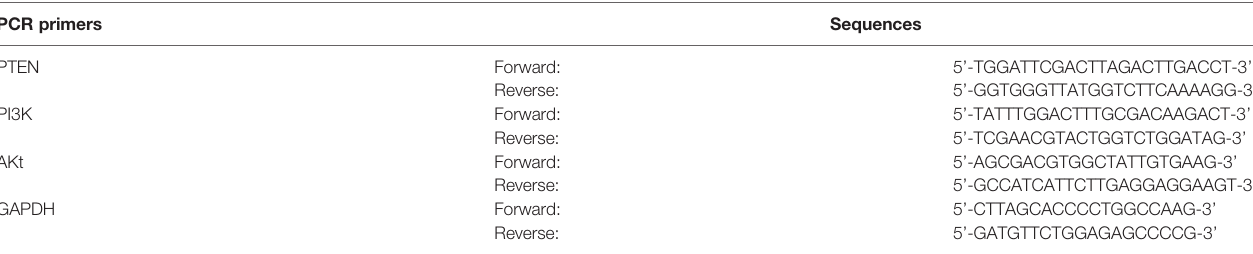
TABLE 2 | Primer sequences of PTEN, PI3K, and